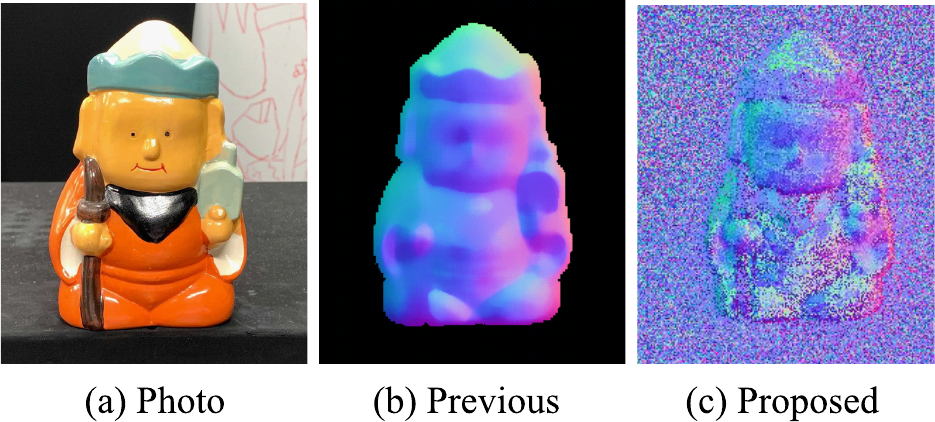
Figure 10. Comparison: ( a ) target object, ( b ) the estimated surface normal of previous method, and ( c ) the estimated surface normal of proposed